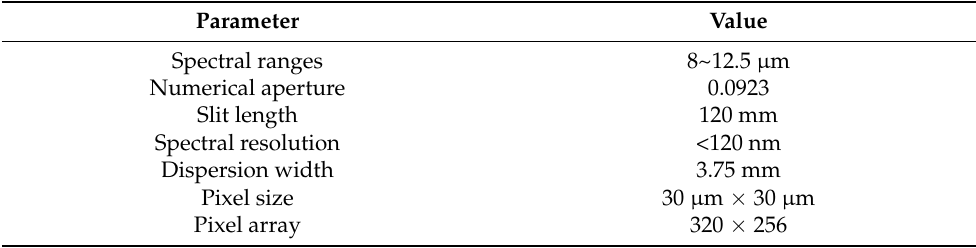
Table 1. Main specifications of the LWIR imaging